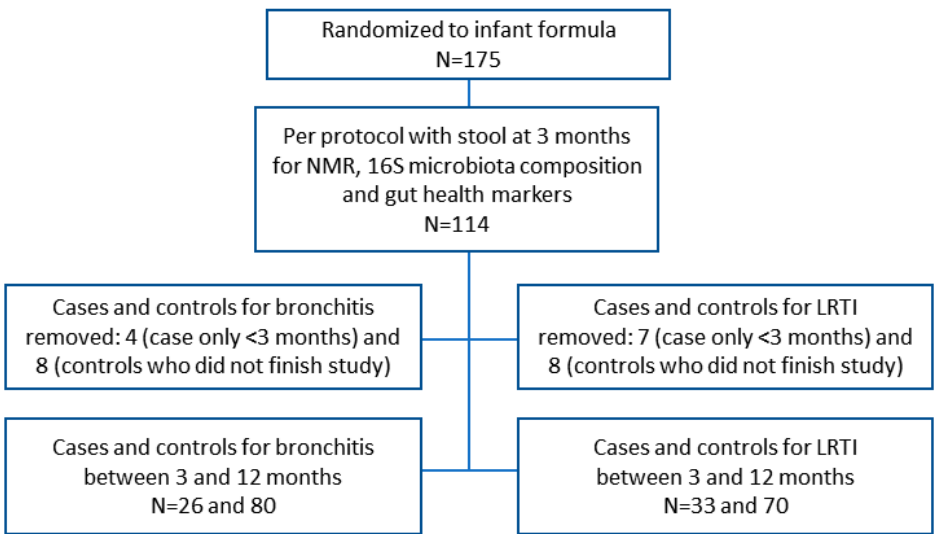
Figure 1. Subject flow chart showing the number of per protocol formula-fed infants with stool sample at three months of age, by controls and cases who experienced at least one reported bronchitis or lower respiratory tract infection (LRTI) between three and 12 months of age.